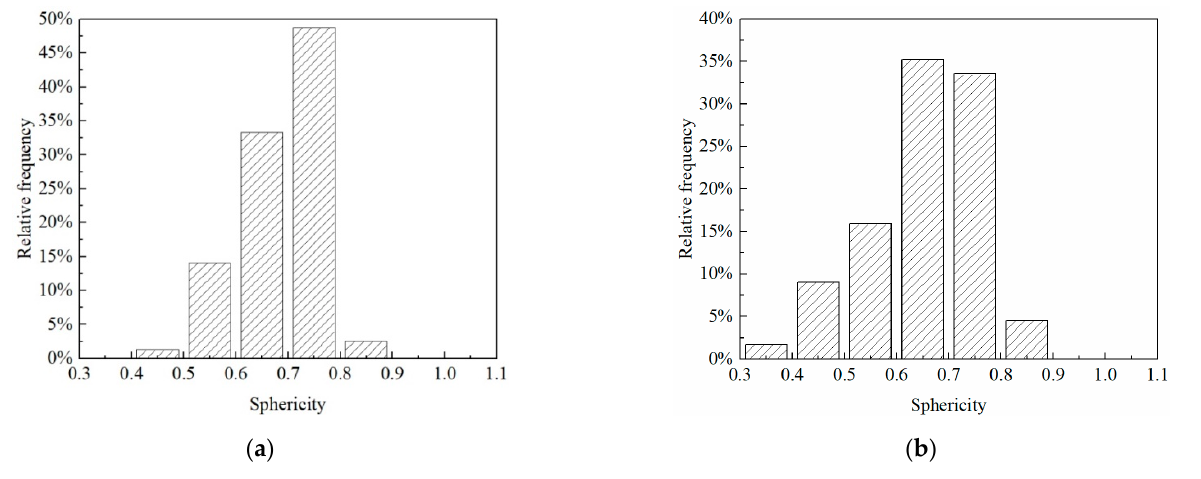
Figure 6. The sphericity distribution of pores: ( a ) untreated sample; ( b ) consolidated sample.